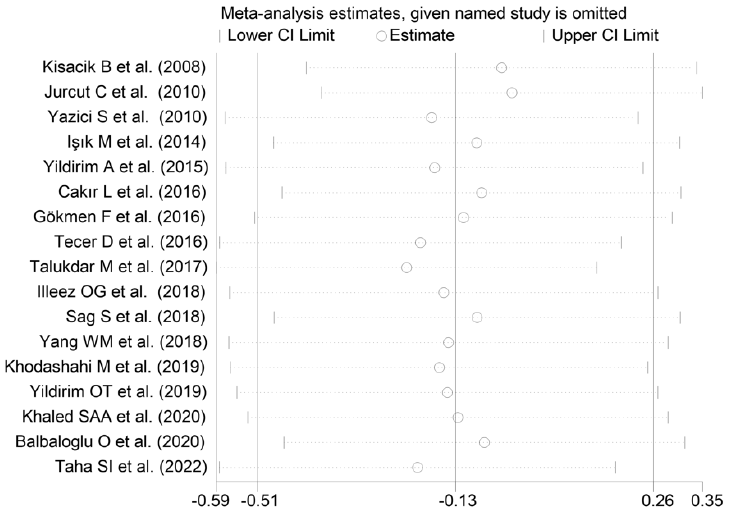
Figure 3. Sensitivity analysis of the association between the mean platelet volume and rheumatoid arthritis. For each study, the displayed effect size (hollow circles) corresponds to an overall effect size computed from a meta-analysis excluding that study.